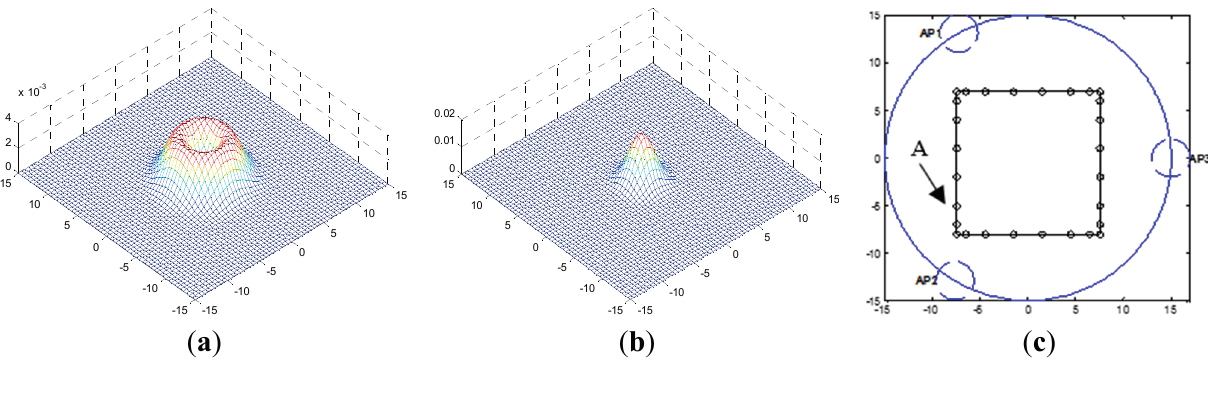
Figure 17. PDFs of the high- and low-speed models and the original